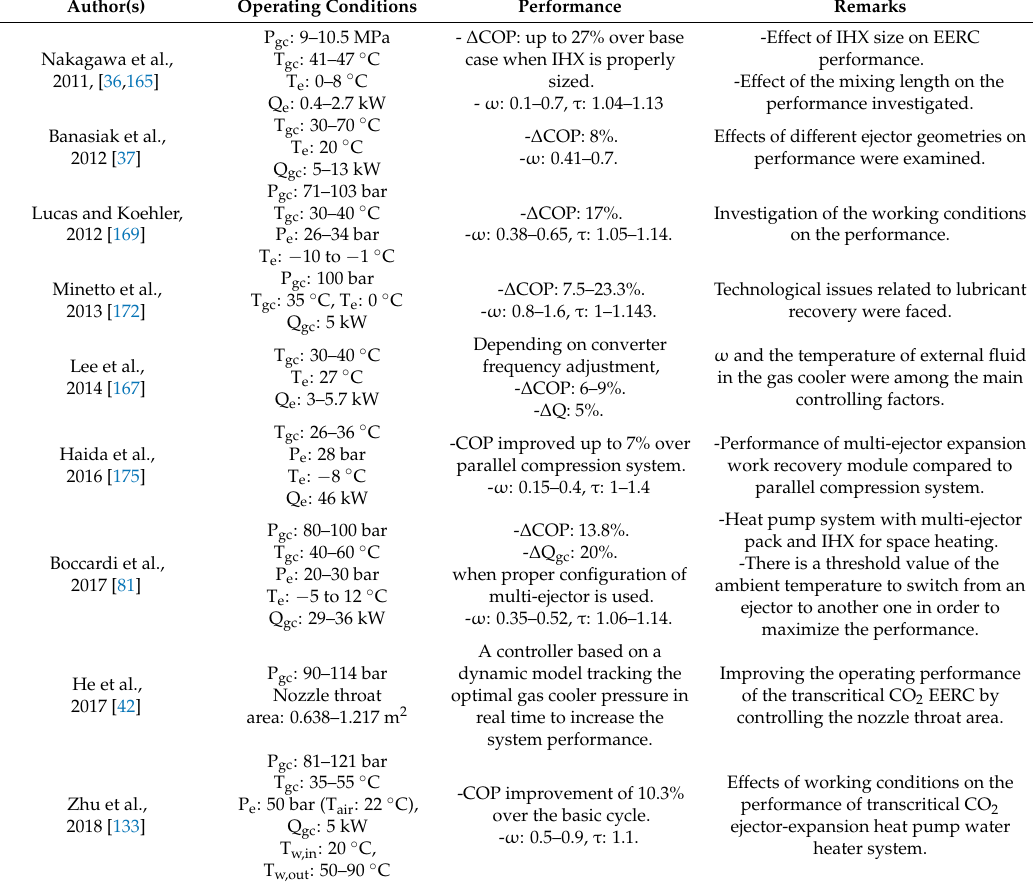
Table 7. Selection of EERC relevant experimental studies (transcritical CO 2